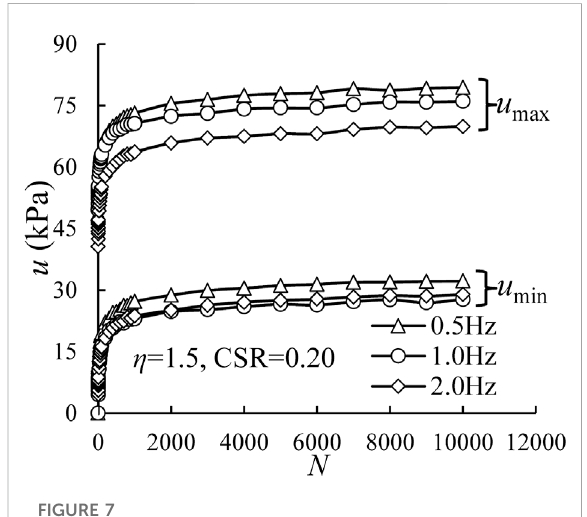
FIGURE 7 Variations of excess pore water pressure with number of cycles under different f values for CSR = 0.20 and η = 1.50.